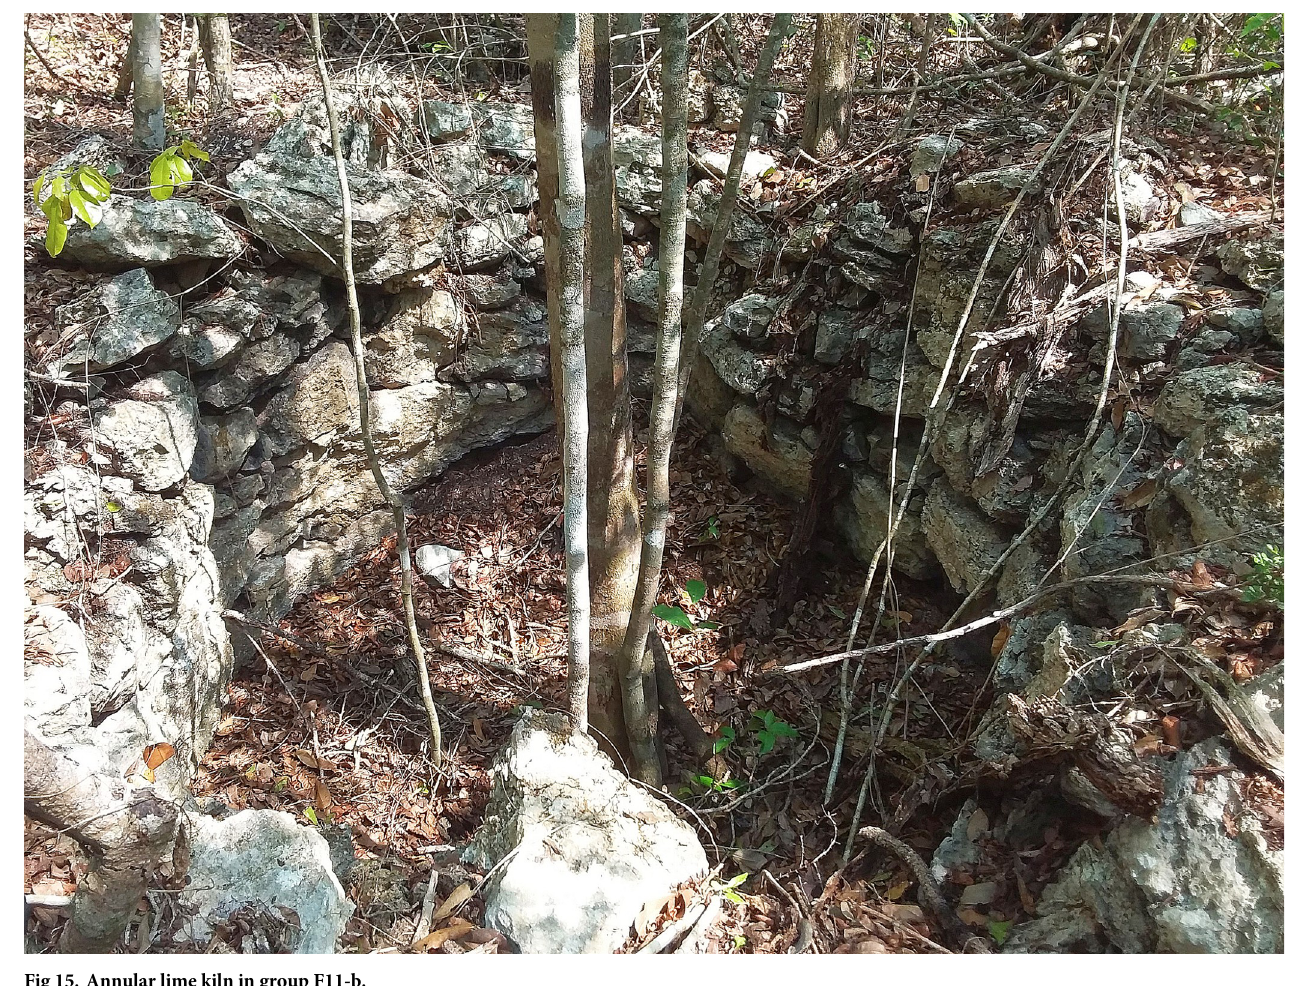
Fig 15. Annular lime kiln in group